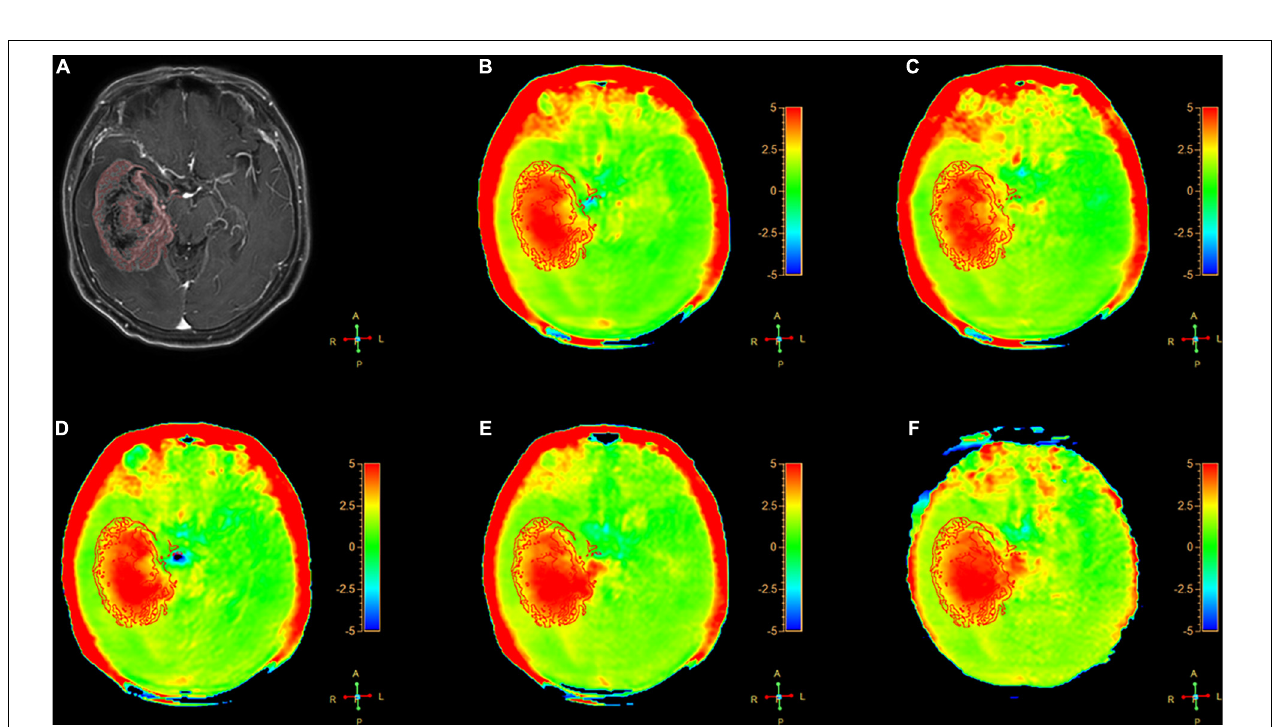
FIGURE 4 | A 54-year-old female patient with gliomas tumors (Grade III) in brain: (A) Gd-T1W; (B–F) APTw images by SENSE (AF 1.6) and CS-SENSE (AFs of 2, 3, 4, and 5). The ROIs were obtained manually on the Gd-T1W image and copied to the others as shown.